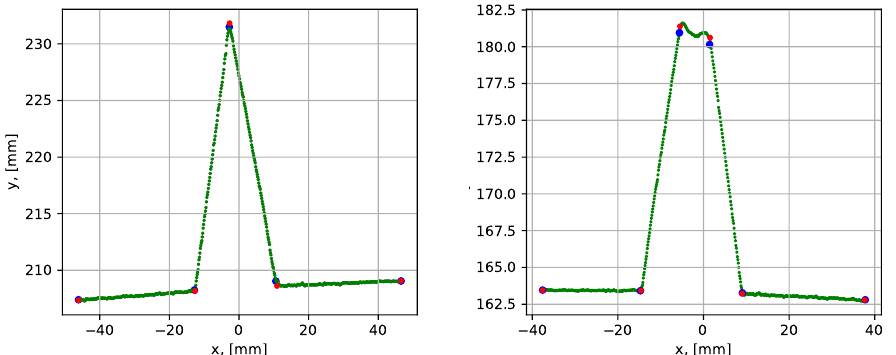
Figure 21. Parametrization results with groove corner points for datasets 4 (to the left) and 5 (to the right). The blue dots show the result before the iterative error elimination procedure and the red dots show after.